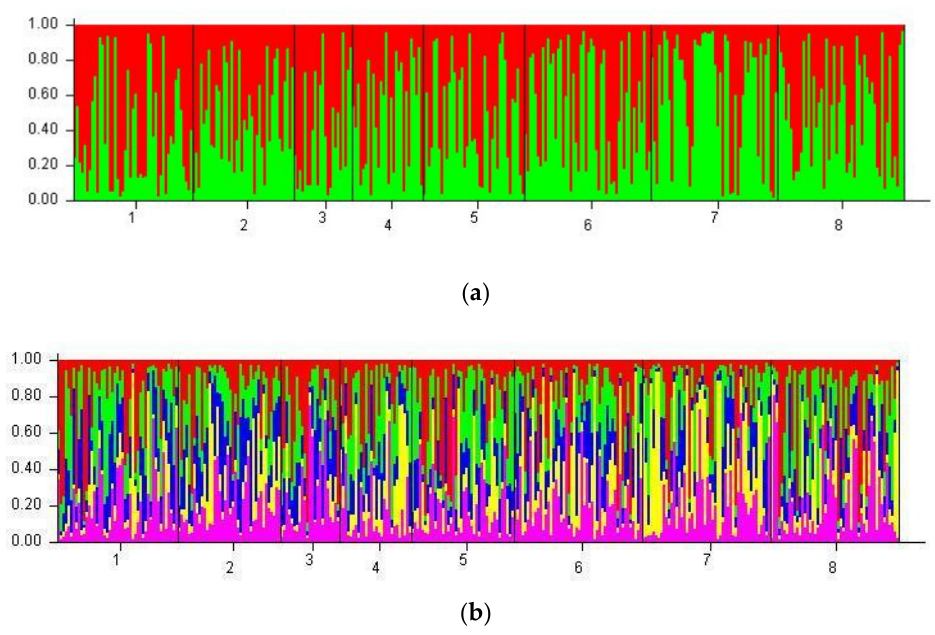
Figure 3. STRUCTURE bar plots of nSSR data ( n = 328 trees); ( a ) for K = 2; and ( b ) for K = 5 referring to a single population code from Table 2.